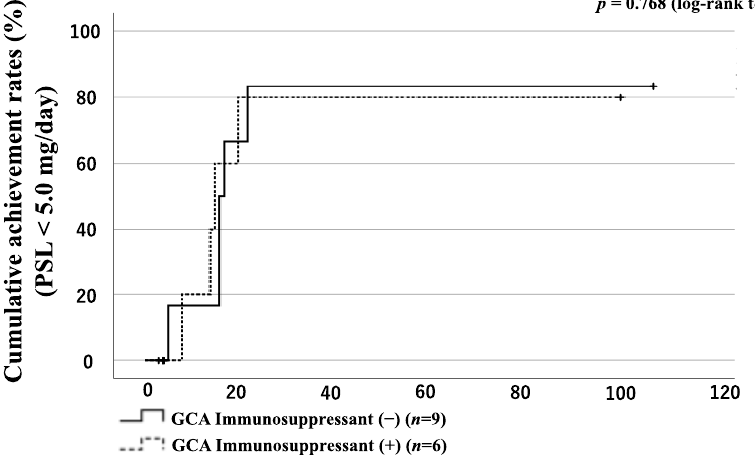
Figure 6. Rates of patients with GCA with and without immunosuppressant achieving the tapered Figure 7. Rates of patients with GCA with and without LVI achievin g the tapered PSL dose (PSL < PSL dose (PSL < 5.0mg/day). Rates of patients with GCA achieving a tapered PSL dose (<5.0 5.0 mg/day). Rates of patients with GCA achieving a tapered PSL dose (PSL < 5.0 mg/day). The propor- mg/day). The proportions of patients who achieved a tapered PSL dose were compared with patients tions of patients who achieved a tapered PSL dose were compared with patients with GCA treated with with GCA treated with or without immunosuppressants using Kaplan–Meier curves. The starting or without LVI using Kaplan – Meier curves. The starting point (0 months) was the date of the initiation of re- mission induction therapy. There was no significant difference between the LVI(+) and LVI( − ) groups. point (0 months) was the date of the initiation of remission induction therapy. There was no significant difference between the immunosuppressant (+) and immunosuppressant ( − ) groups. Table 4. Comparisons of clinical features between LVI(+) and LVI( − ) groups.